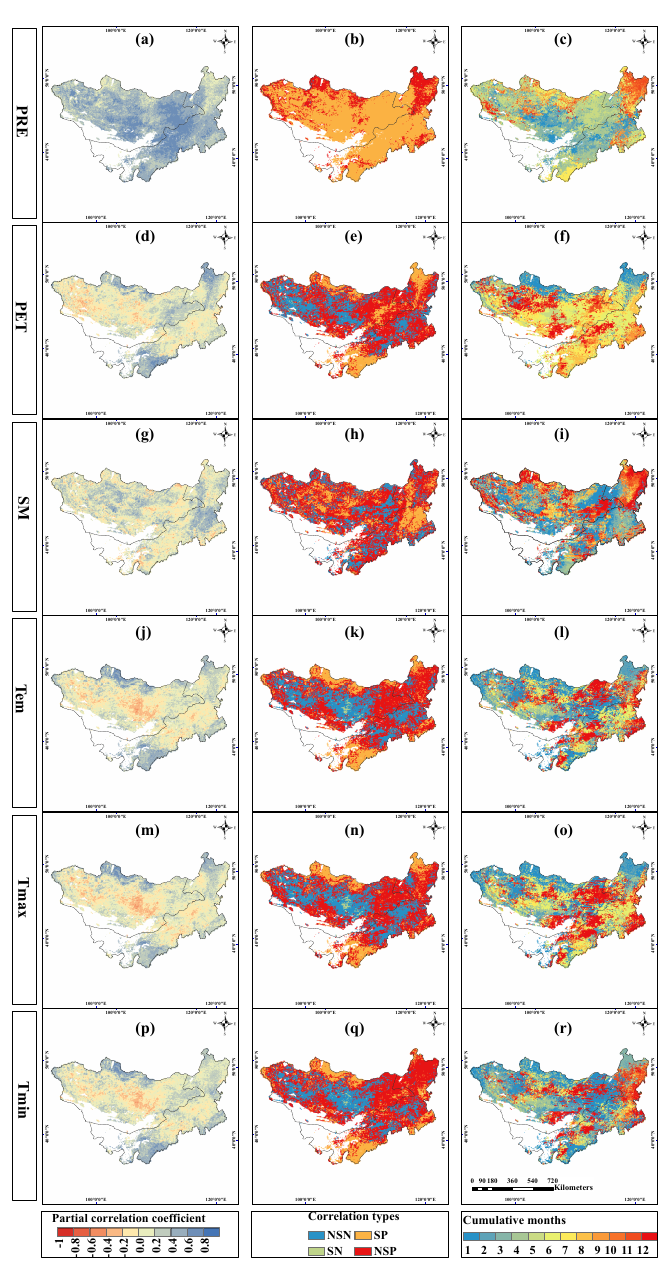
Figure 9. Spatial distribution of the cumulative effects of climatic factors on the NDVI gs for 1982– 2015 in the Mongolian Plateau. The panels on the right-hand side represent spatial distribution of the maximum partial correlation coefficients (i.e., R accmax − gs ). The panels in the centre represent the type of partial correlation coefficients. The panels on the left-hand side represent the spatial patterns of the corresponding time scales (i.e., accumulated months) where R accmax − gs occurred. NSN: non-significant negative correlation; SN: significant negative correlation; SP: significant positive correlation; NSP: non-significant positive correlation. ( a – c ) PRE(precipitation), ( d – f ), PET(potential evapotranspiration), ( g – i ) SM(soil moisture), ( j – l ) Tem(mean temperature), ( m – o ) Tmax(maximum temperature), ( p – r ) Tmin(minimum